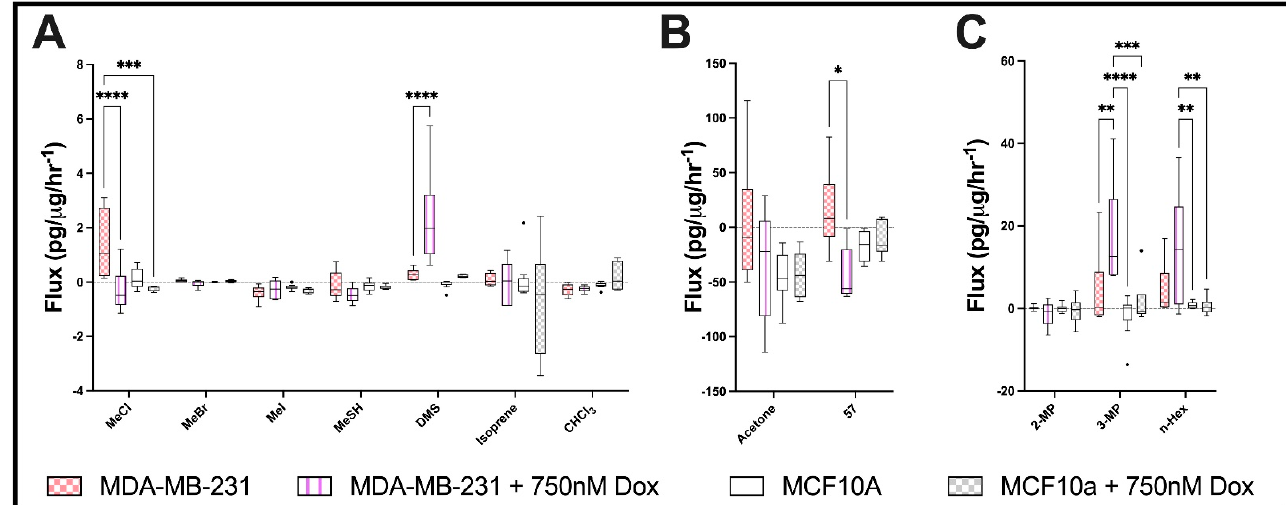
Figure 3. Doxorubicin induces volatile response in breast cell lines. (A-C) Boxplot for select volatile organic compounds (median ± Tukey distribution; n = 6). ANOVA followed by Tukey post hoc test was performed; * p < 0.05; ** p < 0.01; *** p < 0.001; **** p < 0.0001. Doxorubicin has been abbreviated to Dox.